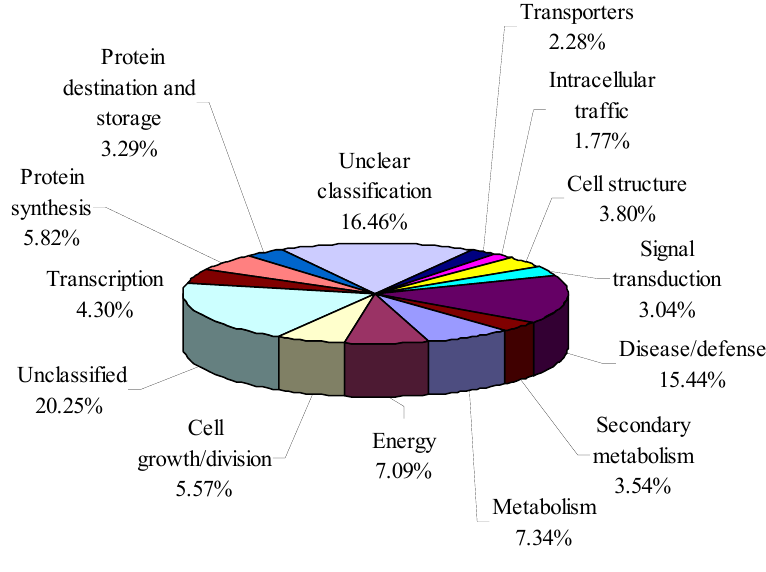
Figure 3. Functional classification of 395 unigenes from “Biqi” fruit EST